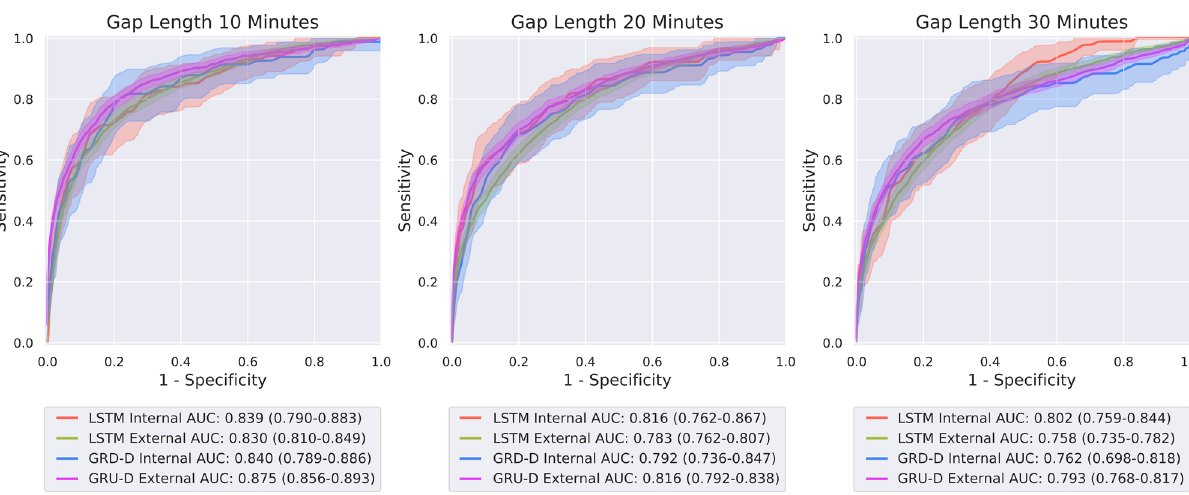
Figure 4. Comparison of ROC curves and corresponding 95% confidence intervals of models trained to make predictions using a 60 min observation window at a gap length of 10 (left), 20 (center), and 30 (right) minutes. Red curves denote performance of the LSTM model on the internal test set, green the LSTM model on the external test set, blue the GRU-D model on the internal test set, and purple the GRU-D model on the external test